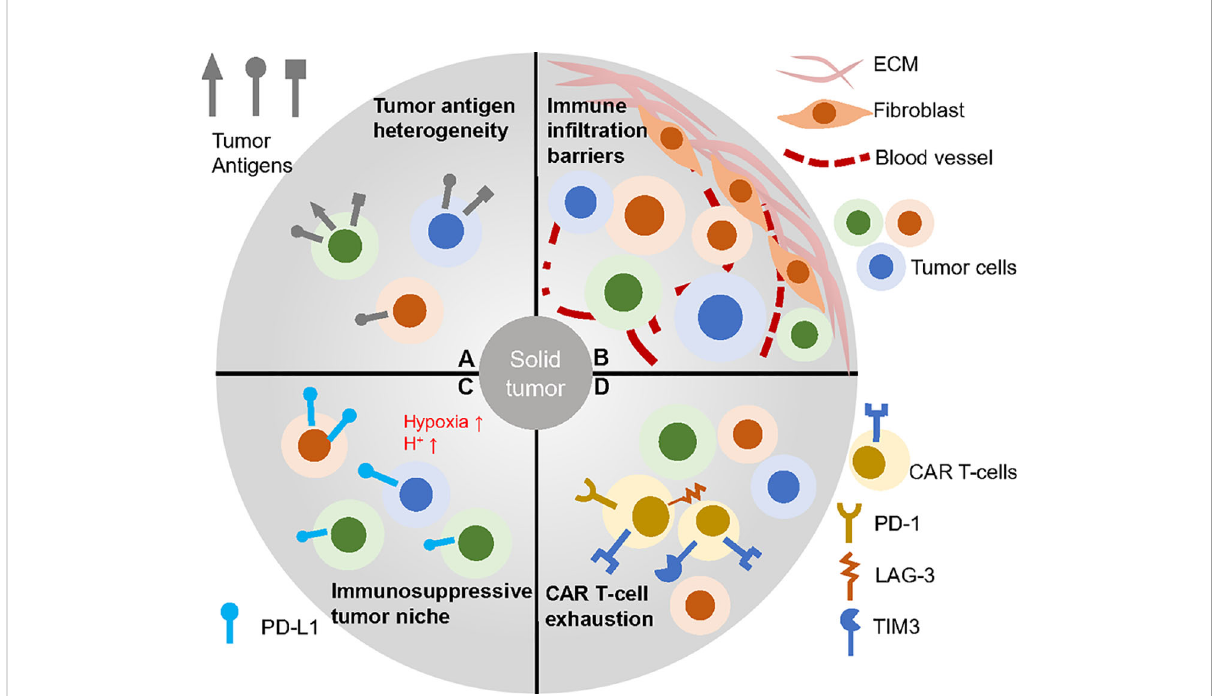
FIGURE 2 CAR T therapy faced challenges in solid tumors. (A) Solid tumor cells baring heterogeneous antigens are dif fi cult to be targeted. (B) Complex tumor barriers inhibit immune in fi ltration. (C) Many factors contribution to the immunosuppressive environment such as low pH, hypoxia and immune check point blockage molecules. (D) CAR T-cells within the solid tumor often go exhausted, which impairs ef fi